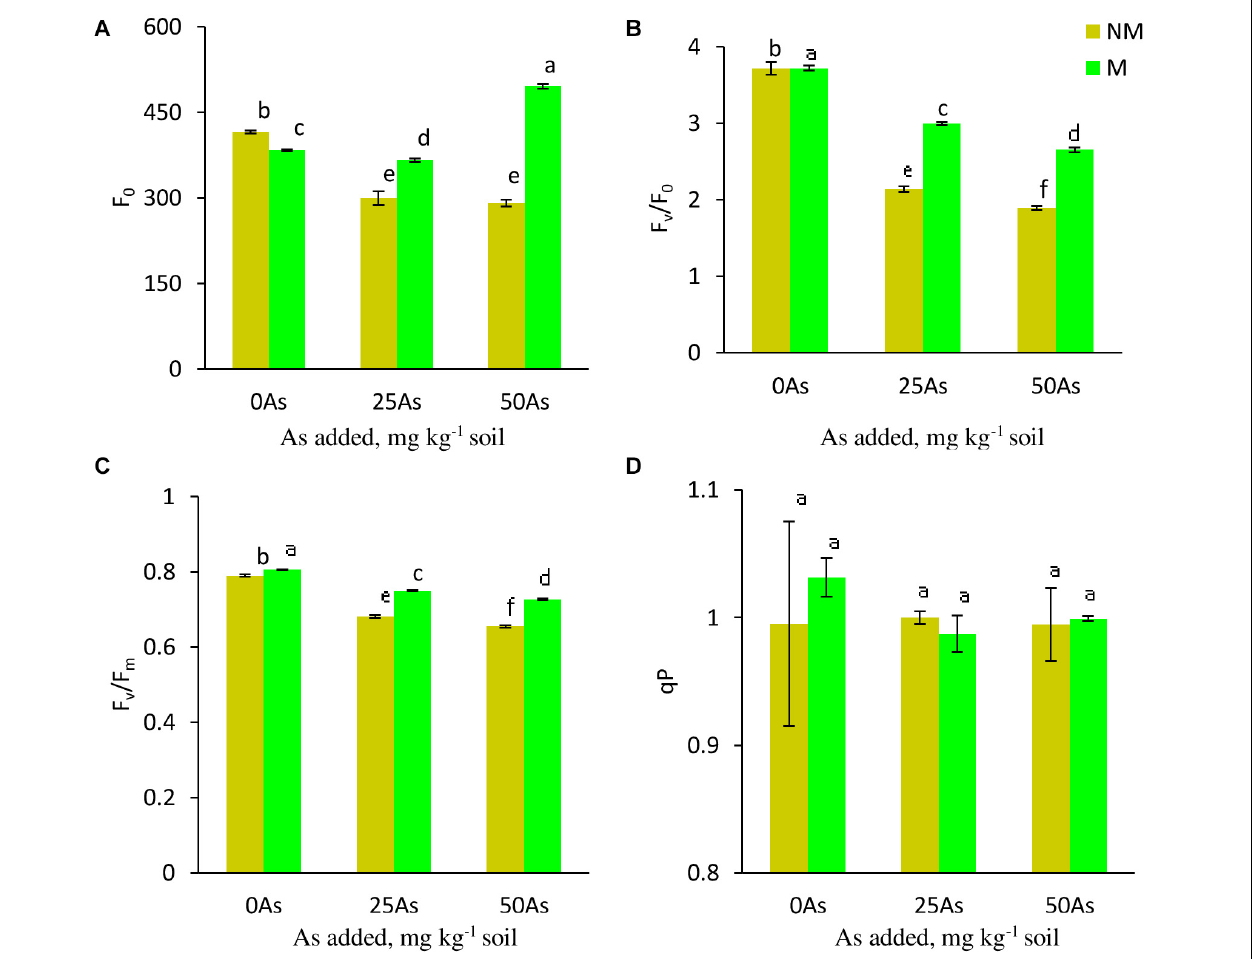
FIGURE 3 | Chl a fluorescence (A) minimal fluorescence, Fo; (B) potential efficiency of PSII, Fv/Fo; (C) maximum efficiency of PSII, Fv/Fm; and (D) photochemical quenching coefficient, qP, in leaves of Triticum aestivum in response to Rhizophagus intraradices inoculation (M, mycorrhizal; NM, non-mycorrhizal) and As addition to the soil. Values represent means of three biological replicates ± SD. Different letters represent significant difference at p ≤ 0.05 , derived from Tukey’s honestly significant difference (HSD). 0As, 0 mg As kg − 1 soil treatment; 25As, 25 mg As kg − 1 soil treatment; 50As, 50 mg As kg − 1 soil treatment.